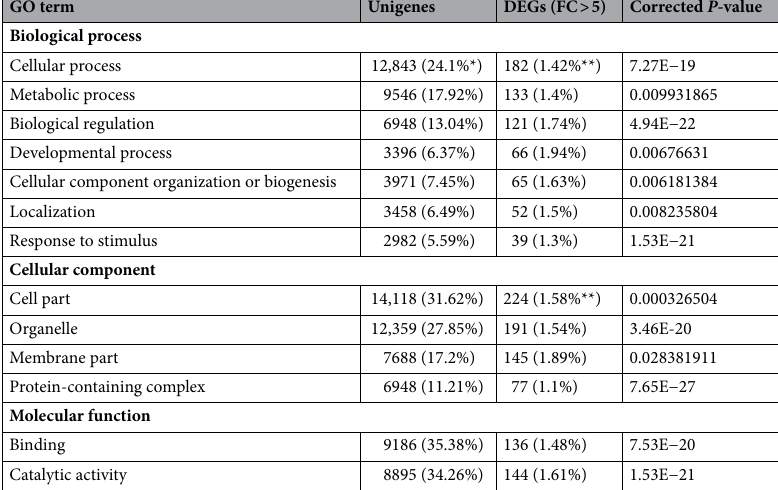
Table 3. Significantly enriched GO terms in the DEGs coregulated by cold stresses. * The percent of unigenes in the relevant GO term. ** The percent of DEGs (FC>5) in the relevant GO term.